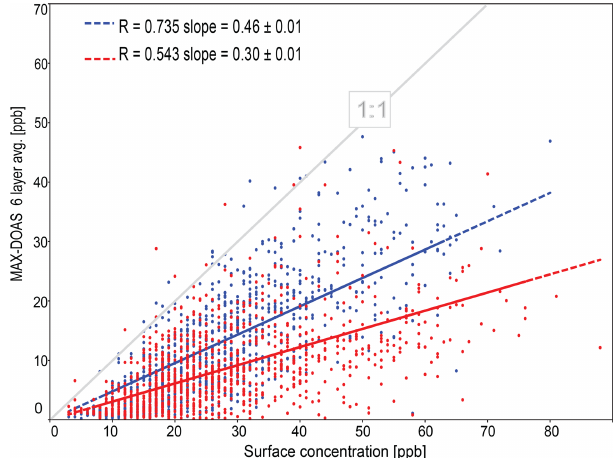
Figure 9. Correlation plot of the MAX-DOAS six-layer VMR aver- ages vs. the surface measurements shown separately for clear-sky measurements in which aerosol data on that day were available (blue) and for MAX-DOAS retrievals with no aerosol optical depth availability from AERONET, corresponding most likely to cloudy days